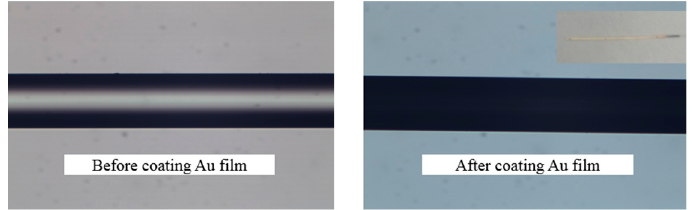
Figure 4. Optical fiber surface micrographs before and after Au film coating.